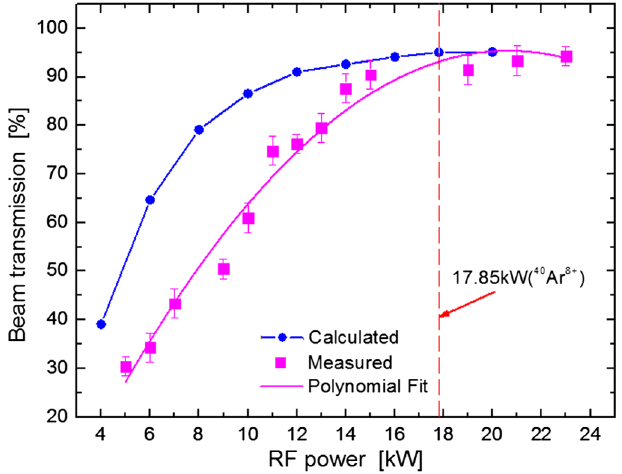
FIG. 26. The measured beam transmission as a function of the rf input power.